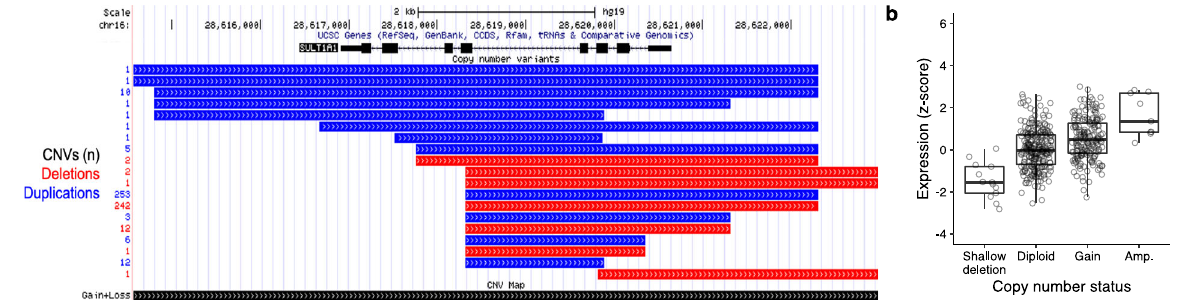
Fig. 1 Characterisation of SULT1A1. a Genomic viewer (UCSC) of the SULT1A1 gene locus with copy number variants; deletion (red) and duplication (blue). b Dosage effect in breast tumours with SULT1A1 copy number variants. CNVs copy number variants.